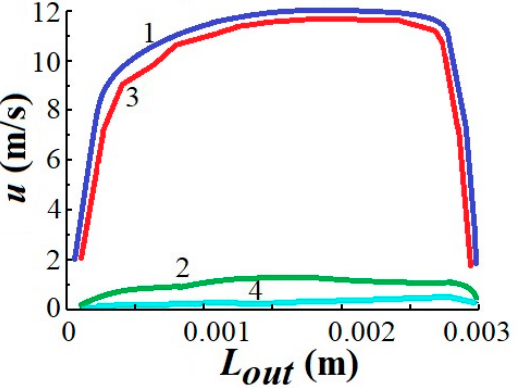
Figure 13. Full inlet velocity curves for straight ( a – c ), profiled ( d – f ), and annular ( g – i ) channels at different swirler channel widths at Re = 2200: ( a , d , g ) b = 0.0015 (m); ( b , e , h ) 0.003 (m); ( c , i ) 0.006 (m); ( f ) 0.009 (m). Lines (1–3), according to Figure 8. The distribution of the total velocity u p and its components along the coordinate axes u y , u x , and u z for the annular channels are presented in Figure 14. The tangential compo- nent of the velocity u y has the biggest value compared to the velocities u x and u z and makes the main contribution to the total velocity value.